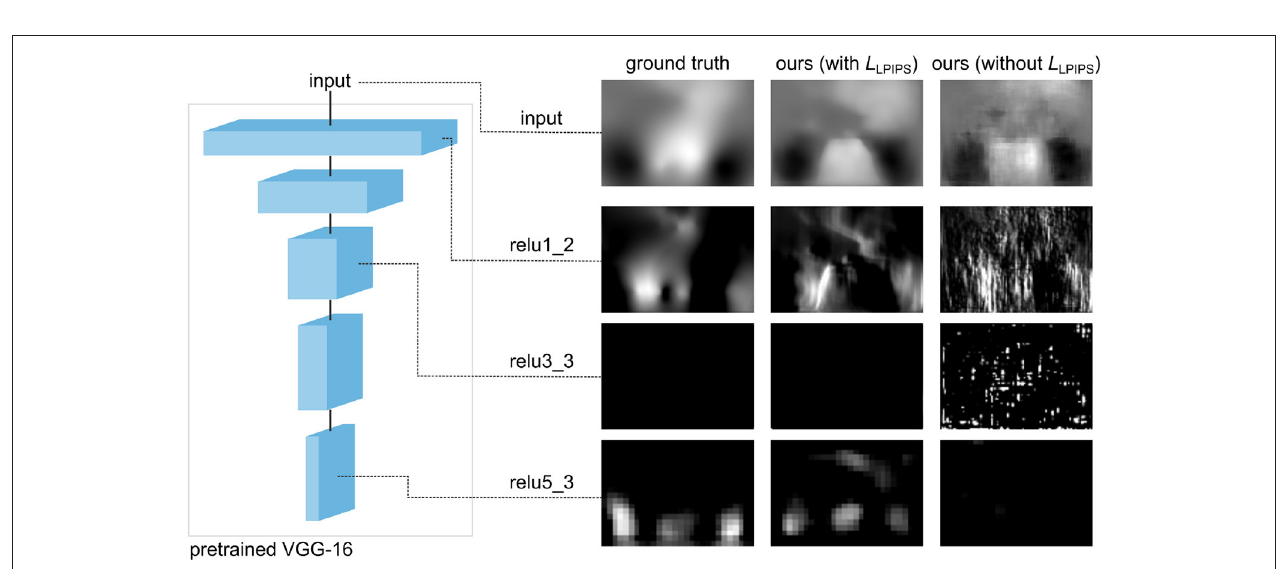
FIGURE 5 | Influence of the loss function on the smoothness of the predicted deformation, for SST gene, section 352. If we use a loss without perceptual similarity, ∼ 3 % of pixels are corrupted. By introducing the L LPIPS term, this is reduced to ∼ 0.1 % .